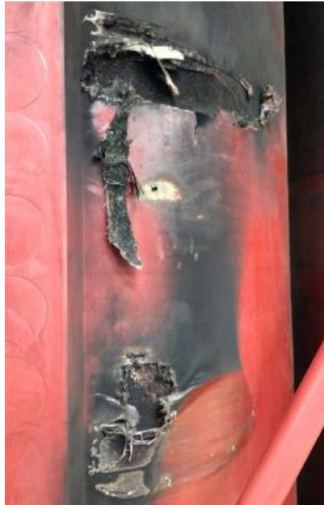
Figure 4. Burn out due to overheating caused by short circuit between turns.